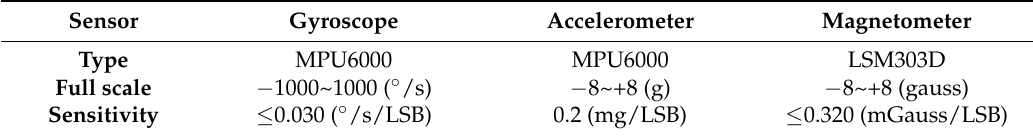
Table 5. Specifications of the